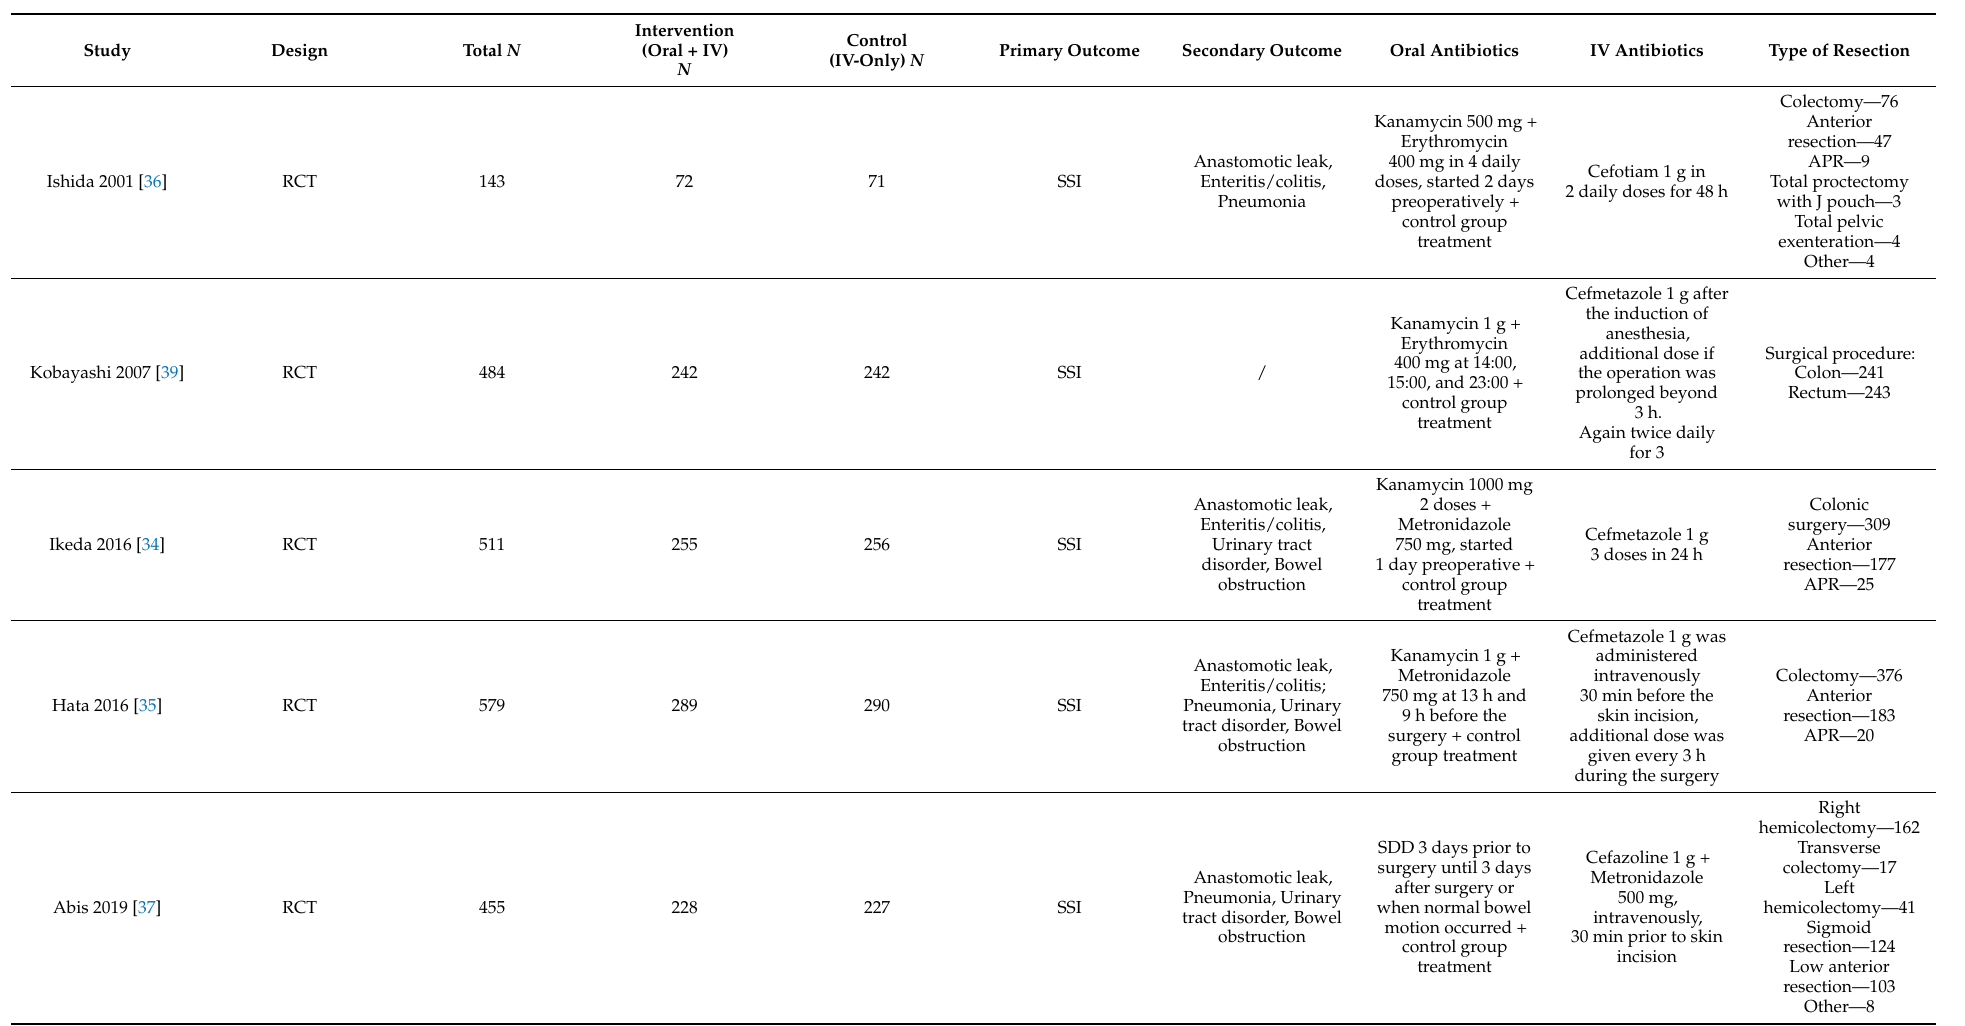
Table 1. Study characteristics of included